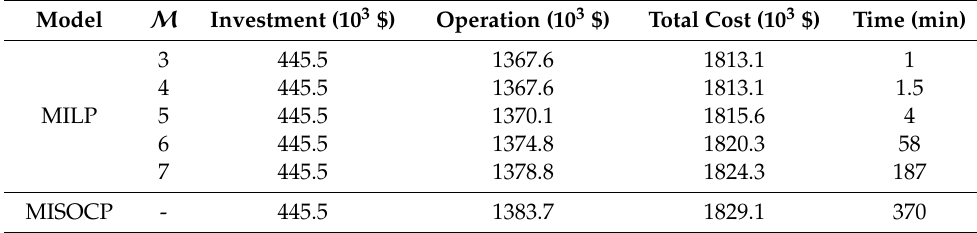
Table 10. Comparison of the Performances of the MISOCP and MILP Models.